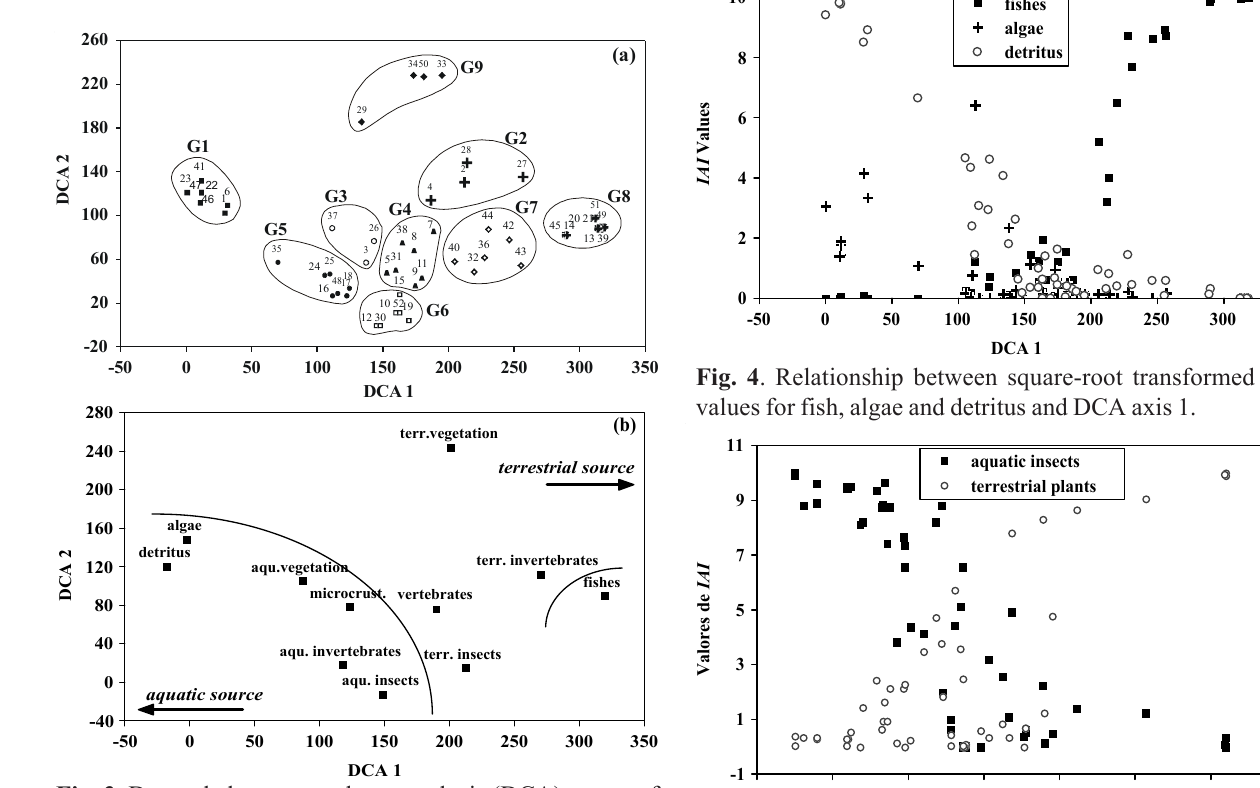
Fig. 3. Detrended correspondence analysis (DCA) scores of the species (a) and food items (b) along axes 1 and 2. Differ- ent symbols in (A) indicate the groups identified by k-means. Species are coded numerically and represented in Table 1.